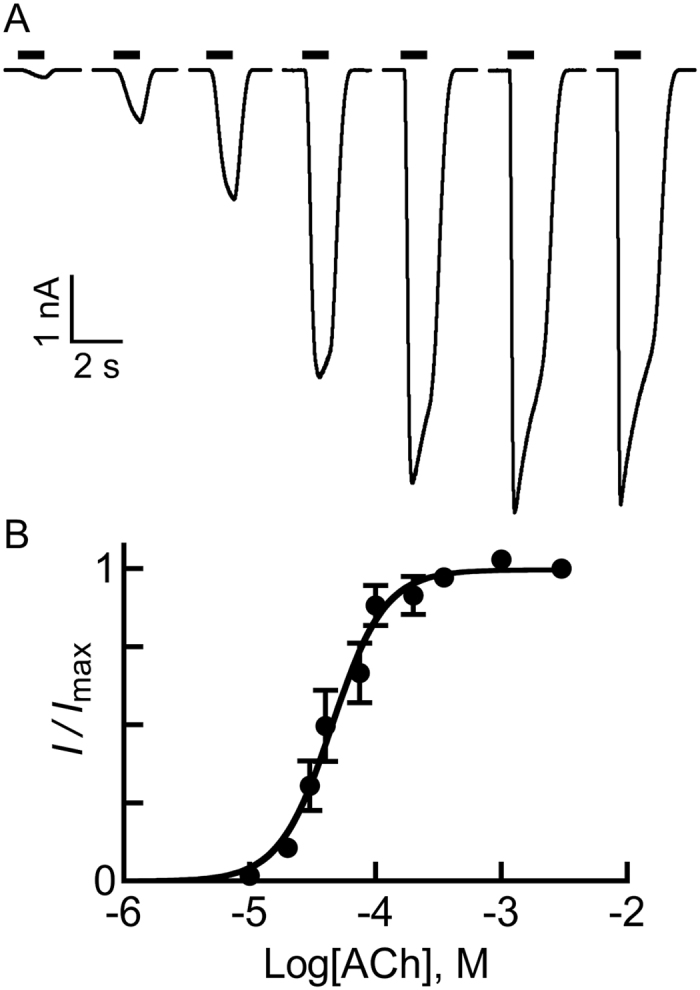
ACh-activation properties of the chimeric α7-GluClβR.(A) Representative current traces evoked by ACh in Chinese hamster ovary (CHO) cells expressing the chimeric α7-GluClβR. ACh was applied for 1 sec at micromolar concentrations of: 10, 20, 30, 75, 200, 1000 and 3000 (black bars). Recordings were performed at −60 mV. (B) A dose-response curve plotted for the responses of the α7-GluClβR to ACh. Data was extracted from experiments performed as in panel A. The curve was fitted to the averaged data points with a non-linear regression using the Hill equation 1 (Eq. 1, see “Materials and Methods”) (r2 = 0.996). Error bars correspond to SEM (N = 12).